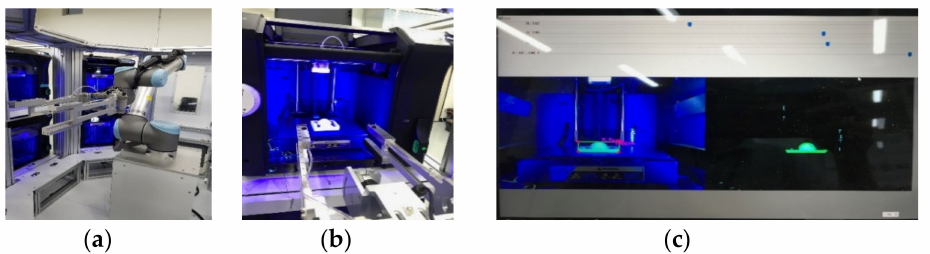
Figure 4. HSV color-space-based robot grasping in previous work in FaaS platform: ( a ) robot handler; ( b ) robot grasping; ( c ) user’s HSV color configuration and monitoring